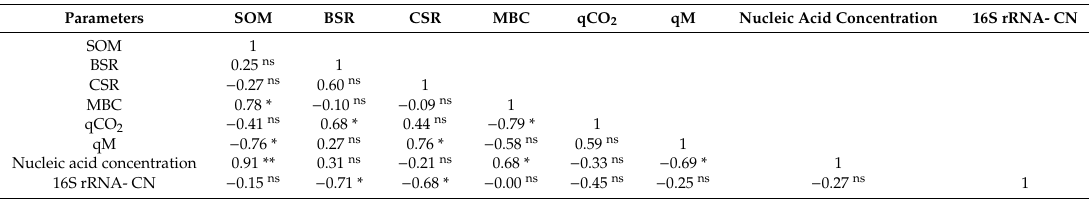
Table 7. Pearson correlation coe ffi cients ( r ) between biological and molecular variables under di ff erent land uses ( n = 9).